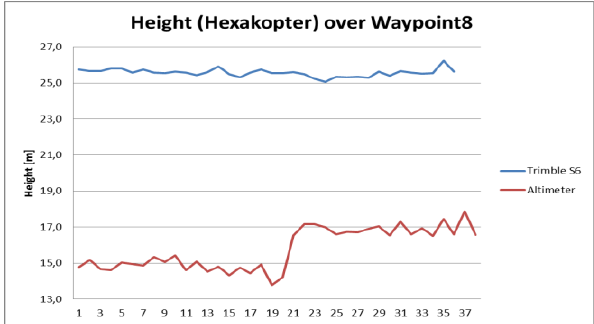
Figure 11. Comparison of the heights over waypoint